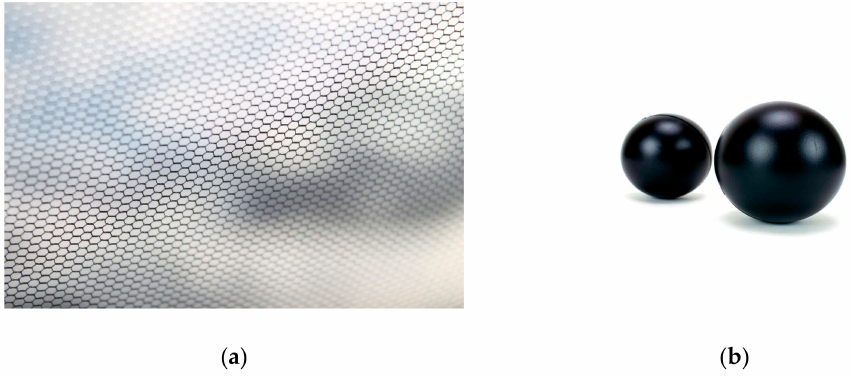
Figure 4. Exclusion deterrents: ( a ) overhead net; ( b ) bird